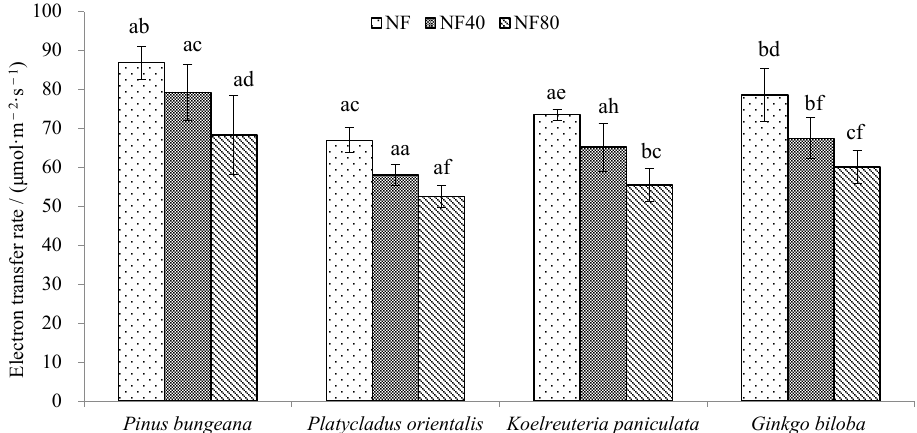
Figure 2. Changes in electron transfer rate of trees under different ozone concentrations. Different letters indicate that there are significant differences between different ozone treatments ( p < 0.05).